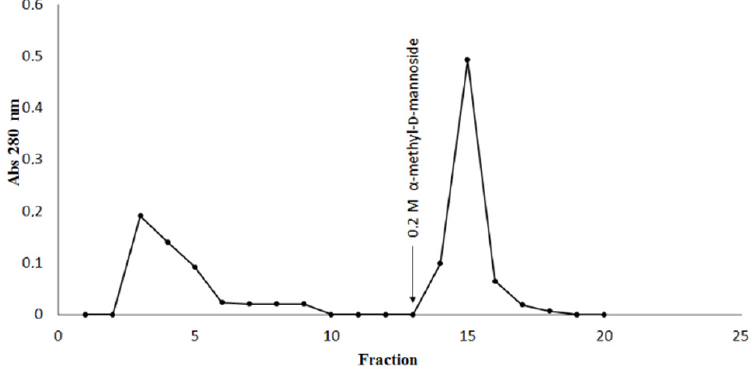
and 5 mM MnCl . Sample (2 mg) 2 2